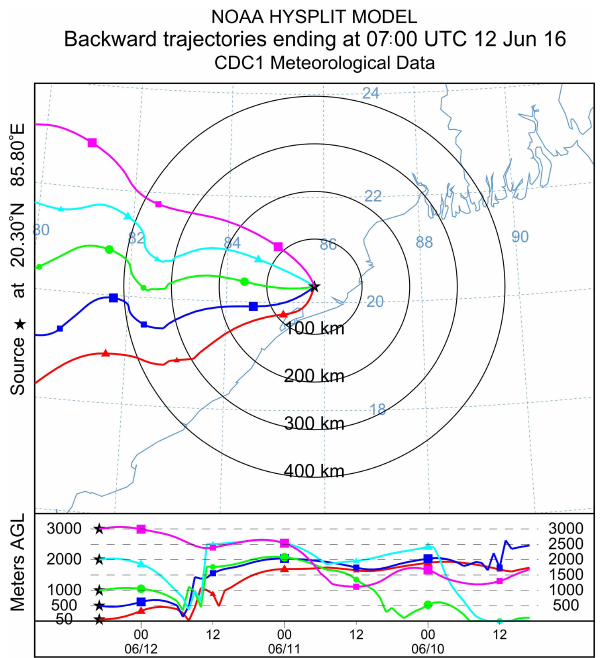
Figure 5. Three-day back trajectories of the air mass arriving at BBR at altitudes 50m, 500m and 1, 2 and 3km during our mea-